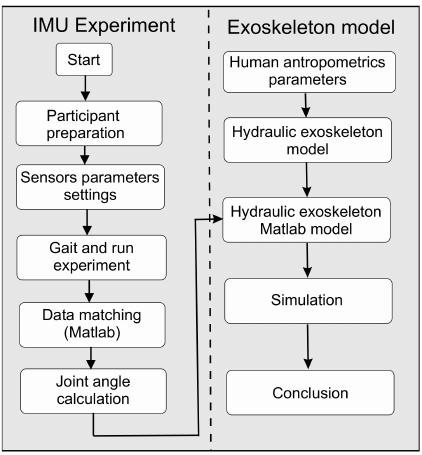
Figure 1. Flowchart of the experimental